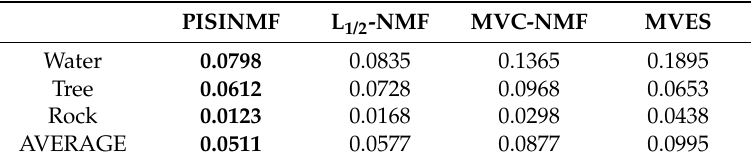
( c ) Tree ( d ) Rock Figure 14. Abundance maps of MVC-NMF, MVES, L 1/2 -NMF, and PISINMF for the Samson dataset: ( a ) Original image ; ( b ) Water; ( c ) Tree; ( d ) Rock.